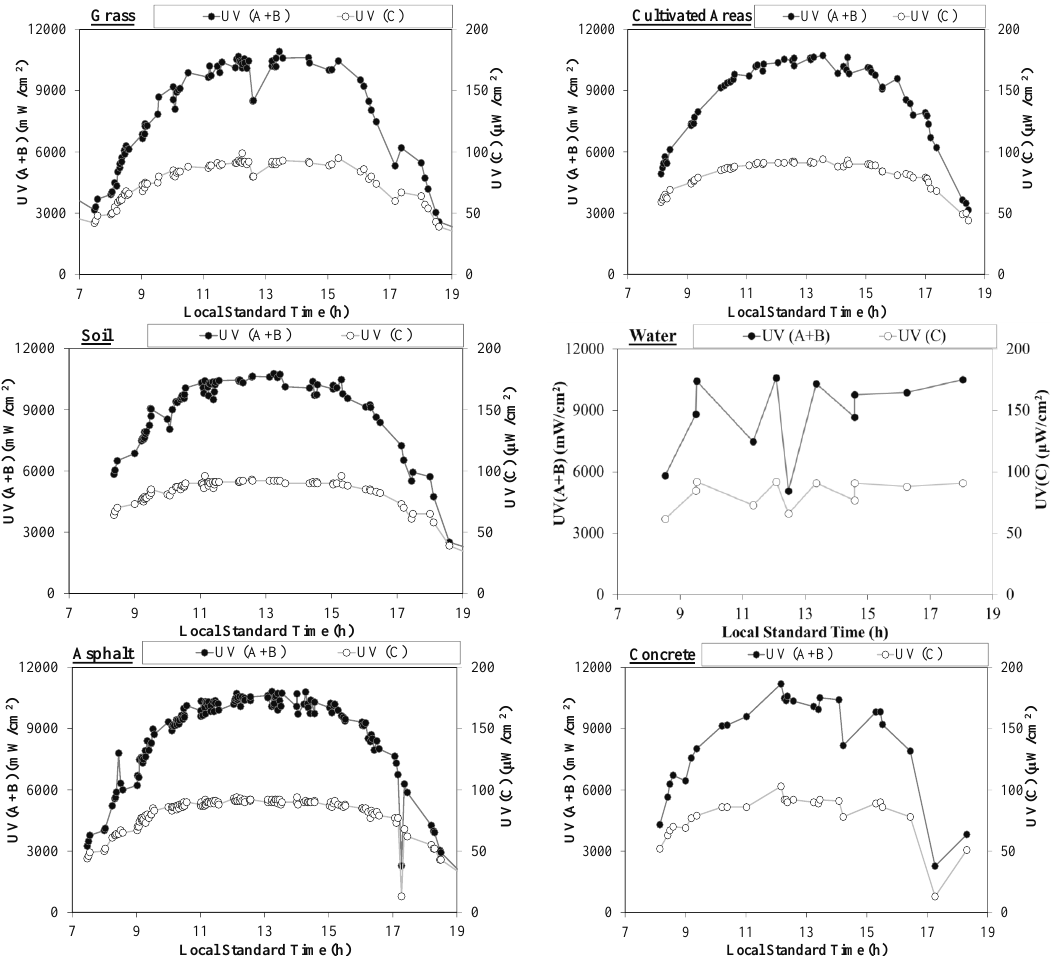
Figure 6. Daily patterns of UV (A+B) and UV (C) solar irradiances across different land cover types (a), under clear sky conditions: for the period (June